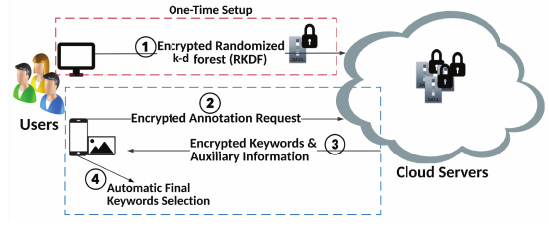
Figure 1. System Model of